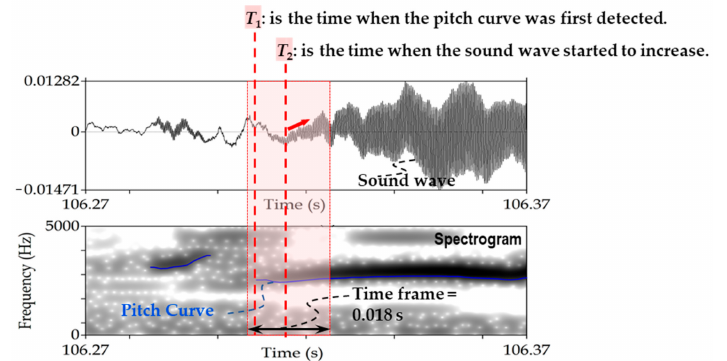
Figure 7. The sound waves and spectrogram at Rec 2 of the UTokyo experiment for detecting the position of Point E (Figure 1b). The highlighted part represents time frame of 0.018